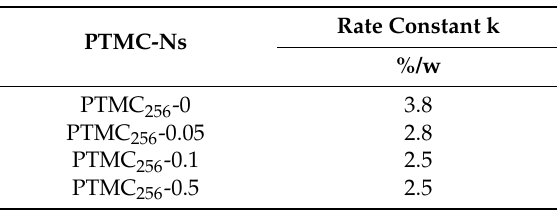
Table 2. The enzymatic degradation rate of BTB cross-linked PTMC-Ns with different cross-linker amount determined from the increase of mass loss.